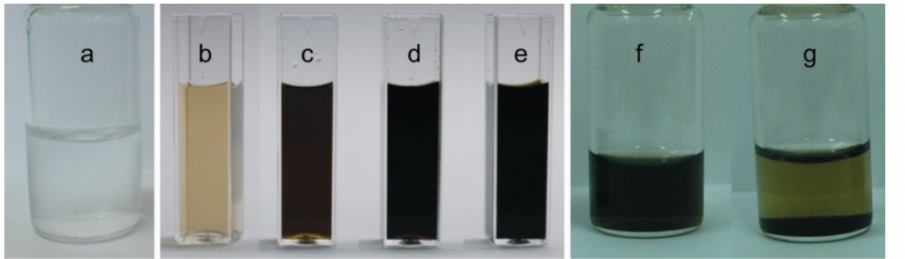
Figure 1. Photographs of electrolyte solutions before ( a ) and after the electro-exfoliated process in 0.01 M of NaOH solution and conditioned at various temperatures of ( b ) 0 ◦ C, ( c ) 20 ◦ C, ( d ) 30 ◦ C, and ( e ) 40 ◦ C for 3. Photograh ( f ) is the “e” stored at 6 months, and after adjusting into acidic condition (pH = 3) ( g